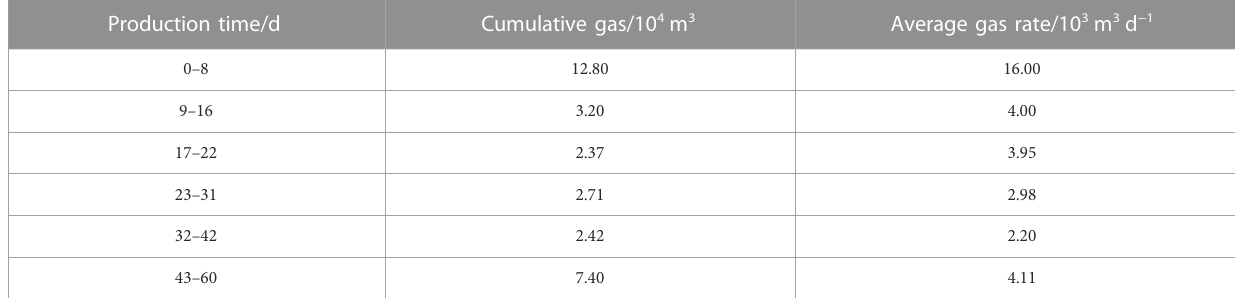
TABLE 2 Gas production of Shenhu area hydrate reservoir in